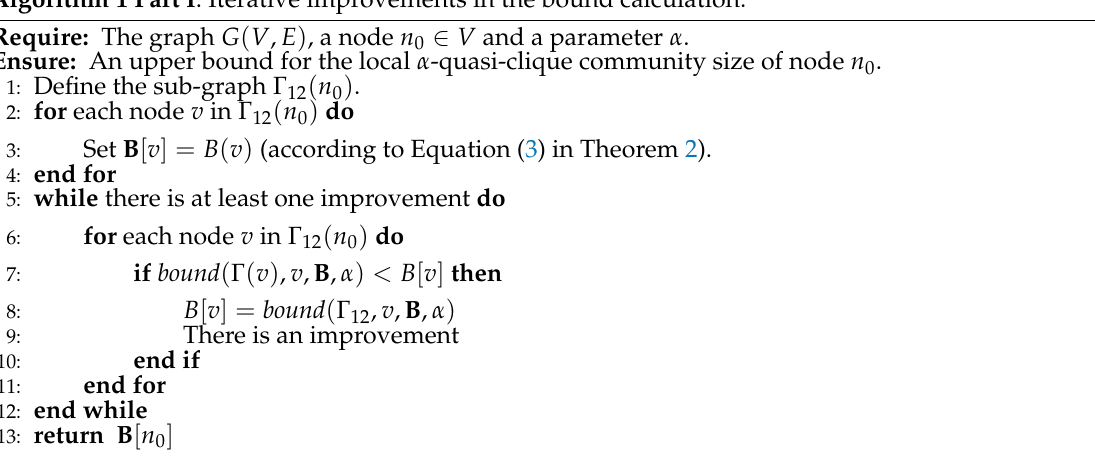
Algorithm 1 Part I : Iterative improvements in the bound